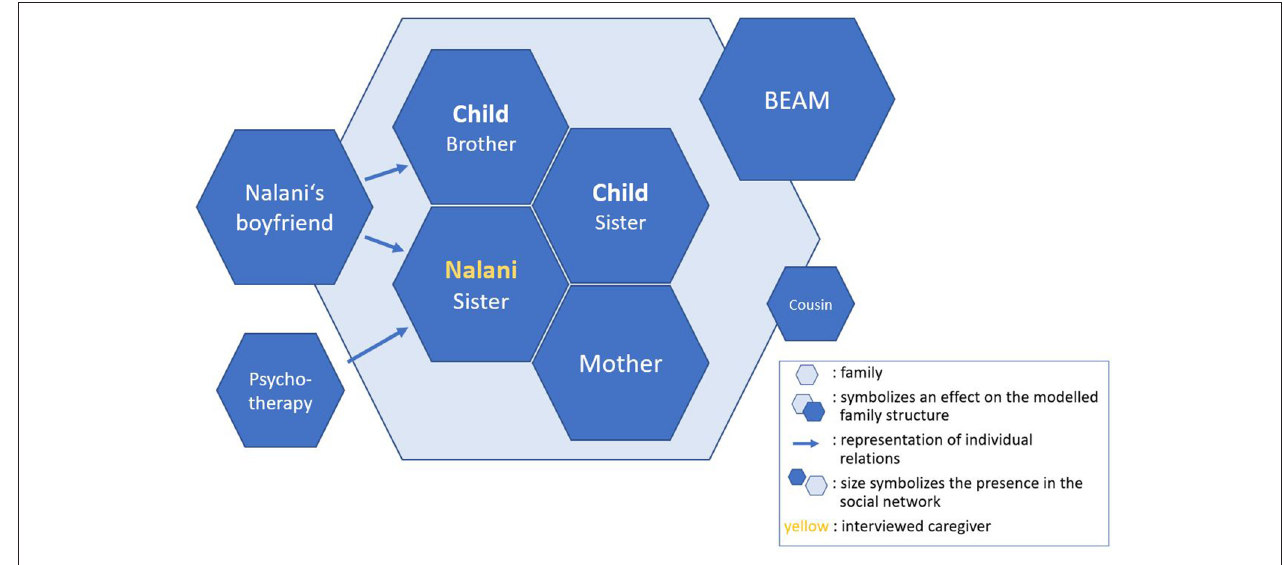
FIGURE 1 | Nalani’s social network.